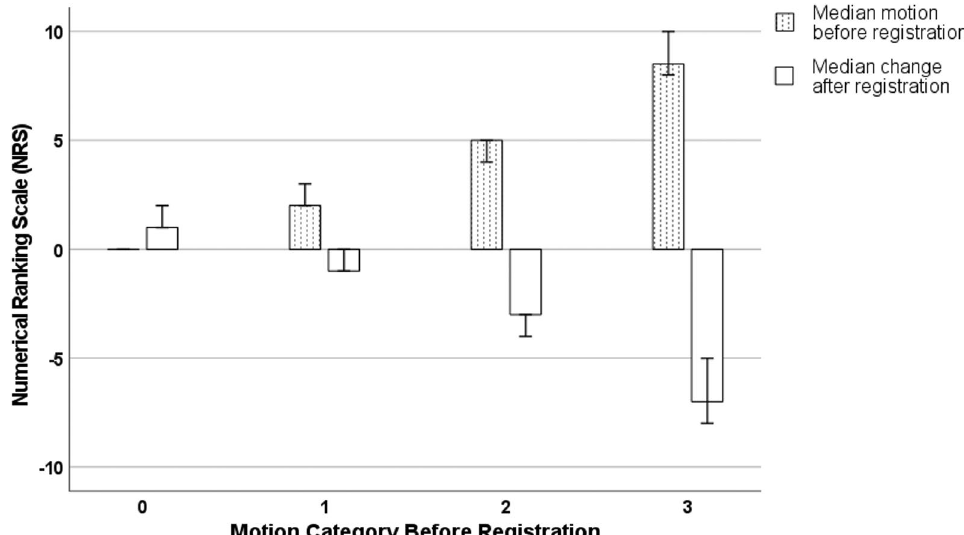
Fig. 4 Impact on registration by motion category. Cases are grouped by motion category before registration. Dotted bars represent median motion on the NRS before registration. Blank bars indicate median change in motion after registration. A 95% confidence level is indicated. Registration resulted in a nonsignificant NRS change for cases initially assigned to categories 0 and 1 ( p initially impaired diagnostic quality due to motion (categories 2 and 3), a significant decrease in the NRS was demonstrated for each category after